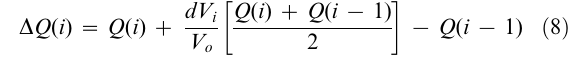
which is then used in the Marquardt minimization algorithm to obtain best fitting values until constant x 2 values were achieved [39,40].